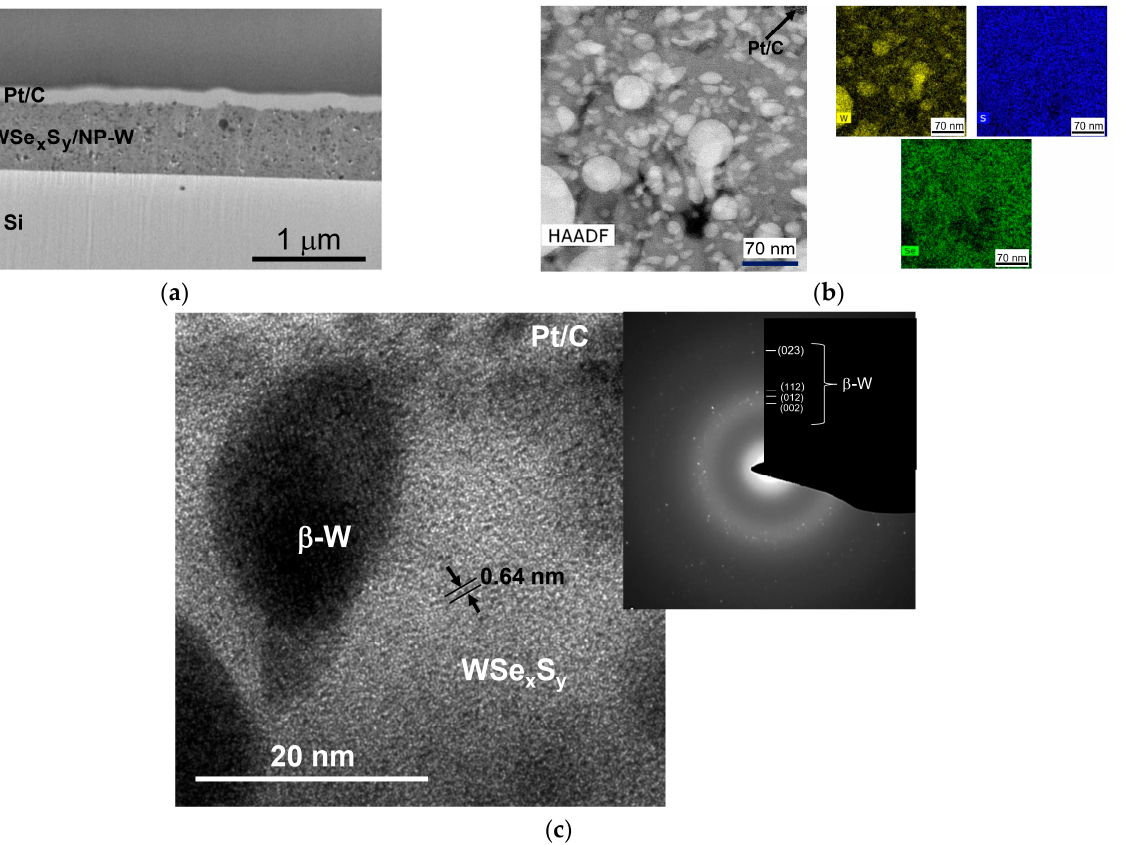
Figure 3. Cross-sectional STEM analysis of a WSe x S y /NP-W coating prepared by RPLD at a H 2 S pressure of 3.6 Pa on a Si substrate: ( a ) a low-magnification TEM image of the coating; ( b ) a high-angle annular dark-field (HAADF) STEM image of the surface layer of the coating (left) and colored EDS elemental maps of W, Se, and S in this local area (right); and ( c ) an HRTEM image of a local area in the surface layer. The inset contains the SAED pattern.